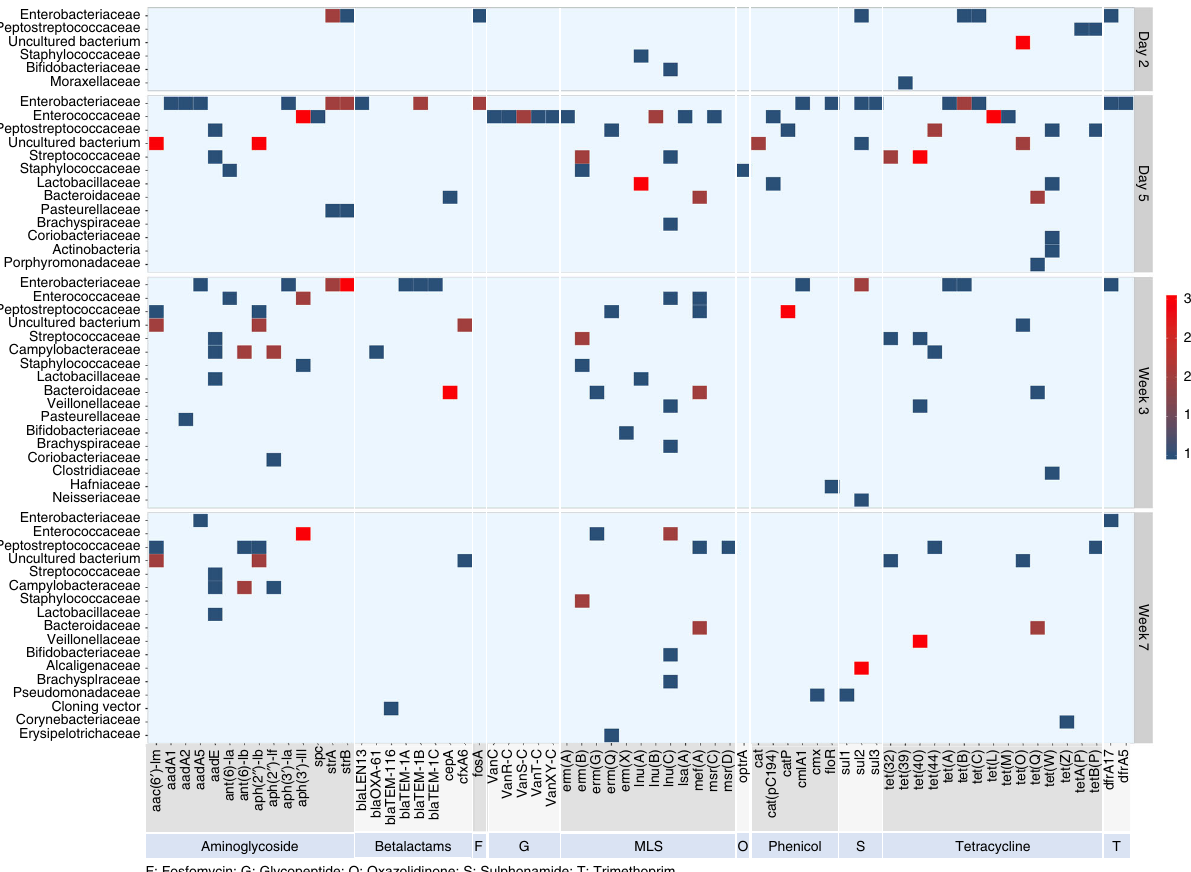
Fig. 5 The predicted bacterial families of 67 transferrable ARGs. ARGs were grouped per class of antibiotics. Bacterial families were ranked, top to bottom, by diversity of ARGs present, with the families harbor the most diversity of ARGs at the top. Data were obtained from the ResFinder